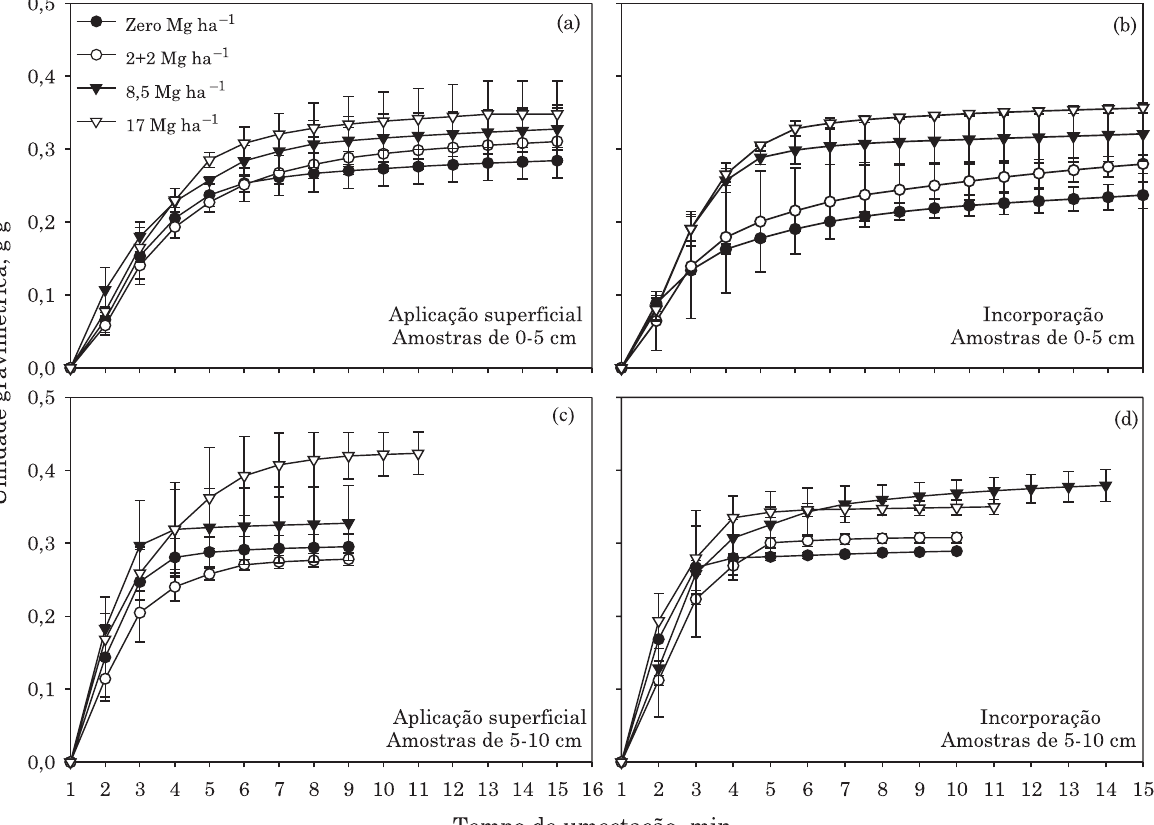
Figura 1. Velocidade de umectação de um Argissolo que recebeu em 1994 diferentes doses de calcário em duas formas de aplicação. Amostras da profundidade de 0-5 cm (a) superficial e (b) incorporado, e de 5- 10 cm, (c) superficial e (d) incorporado. As barras verticais representam o desvio-padrão de três repetições em relação à média.